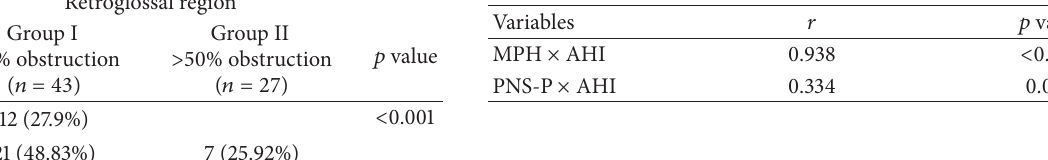
Table 8: Correlations of MPH and PNS-P with